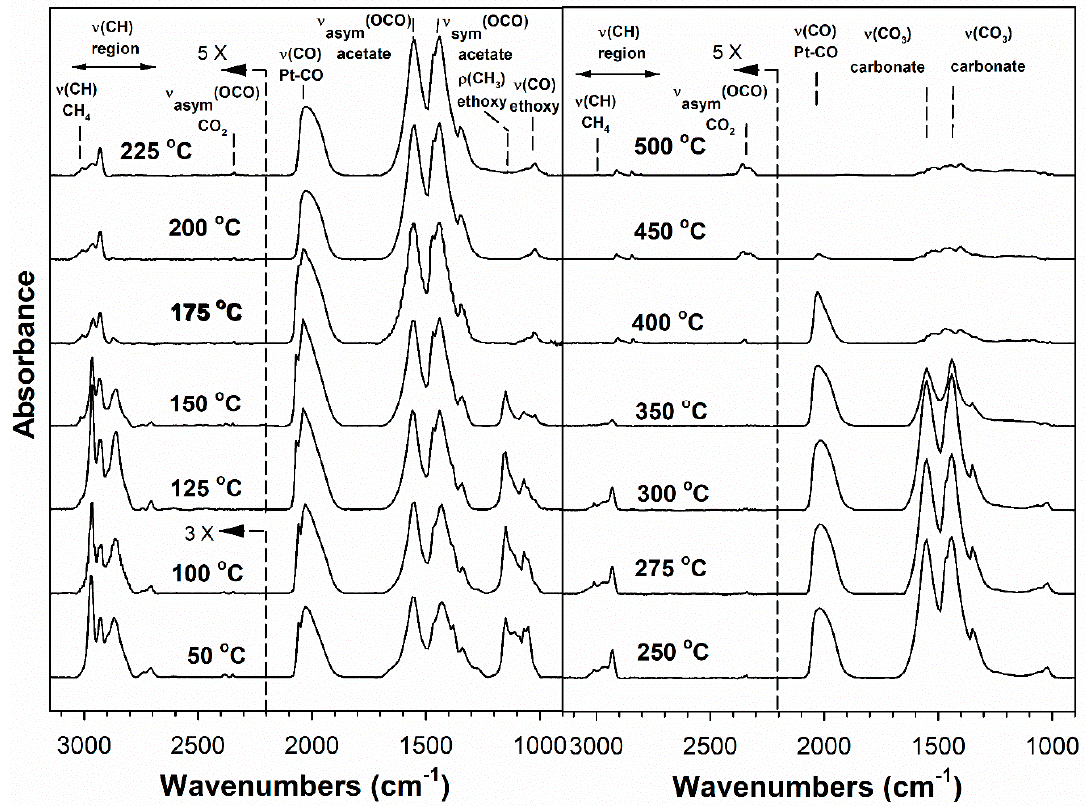
Figure 4. DRIFTS of transient ethanol steam reforming over 2% Pt/ZrO 2 .